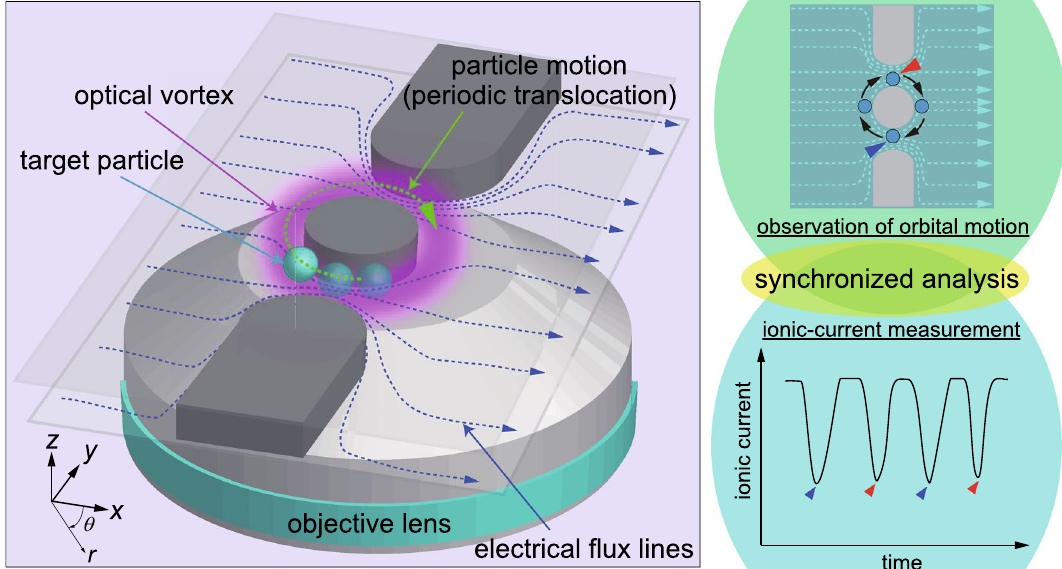
Figure 1. Concept of synchronized resistive-pulse analysis by an optical vortex in a transparent double orifice. Both the height and throat width of the orifice are 3 µ m. (Details about the dimensions are described in the Supplementary Information.) An orbital motion of a single target particle is driven by the optical-vortex beam to periodically pass through the orifices. The translocation event is simultaneously observed by a microscope with an ionic-current measurement. The synchronized resistive-pulse analysis improves the S/N ratio of the resistive pulses by averaging a sufficient number of waveforms for a single particle. The coordinate system used in this study is shown in the left